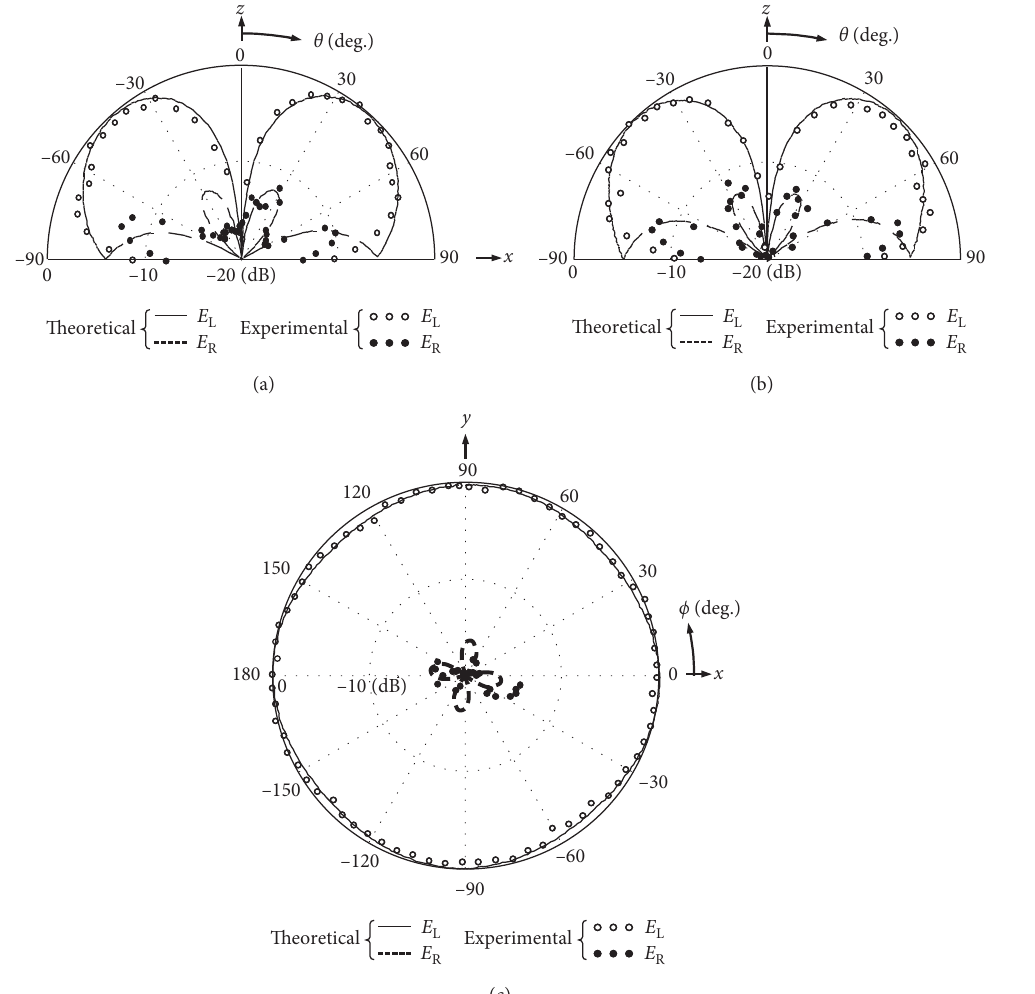
Figure 5: Radiation patterns of spiral-type antenna for ( d is θ � 46 ° . (b) ϕ � 45 ° plane. (c) θ � 46 °